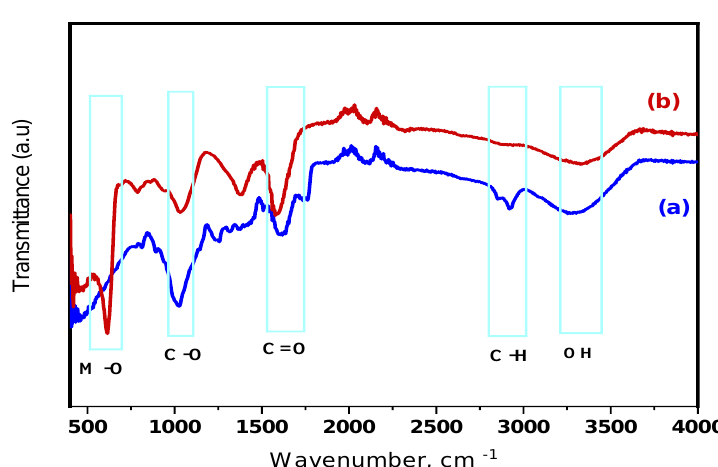
Figure 2. FTIR spectrum of ( a ) Saussurea costus root extract and ( b ) CuO nanoplates.